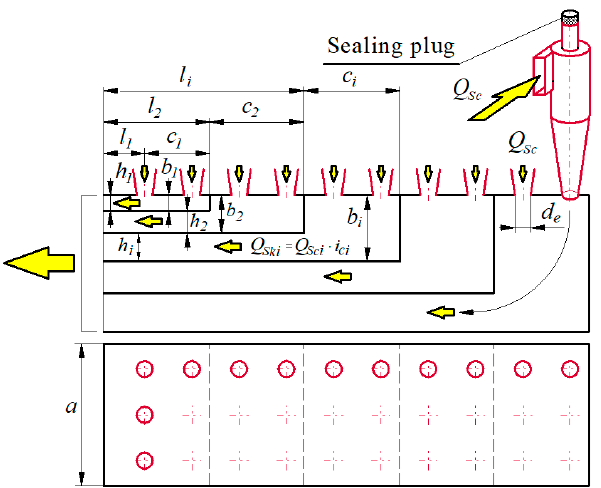
Figure 12. Dust collector segment schematic diagram: a —segment width, b —chamber height, c — chamber length, l —exhaust channel length, d e —discharge opening diameter, h —settling tank total height, h i — i -th channel height, i —channel sequence number.